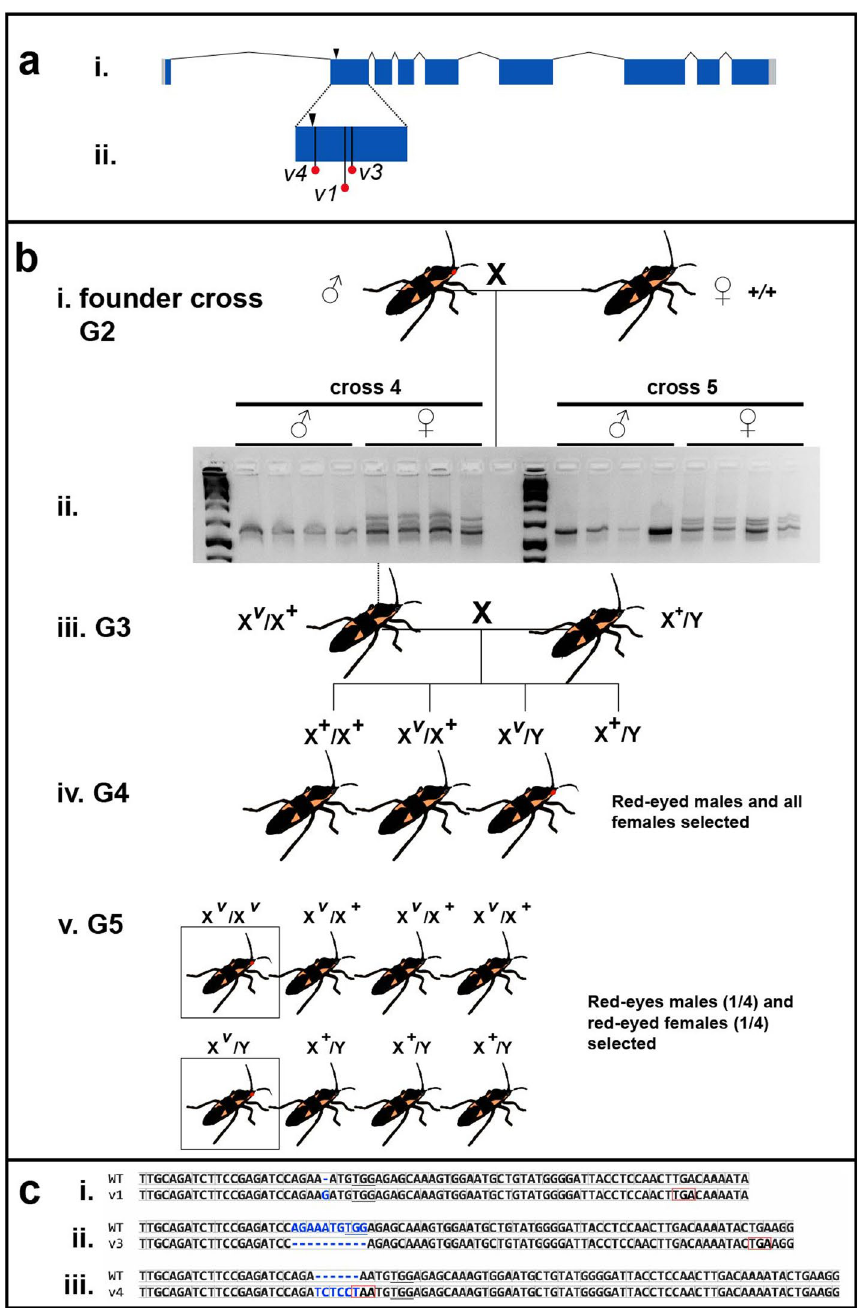
Figure 3. Generation of Of-v mutant lines using CRISPR/Cas9. ( A ) An Of-v gRNA was designed to guide Cas9 to generate a double-stranded break (arrowhead) in Of-v exon 2. (i) Of-v gene structure, with coding DNA sequence shown in dark blue and untranslated regions shown in light gray. (ii) Premature stop codons found in exon 2 of all mutant alleles. ( B ) Crossing scheme to generate homozygous lines from a heteroallelic Of-v mutant stock. (i) Five single crosses were set up between a single red-eyed Of-v G2 male founder (derived from the heteroallelic Of-v population) and three wild-type virgin females. (ii) Of-v exon 2 was amplified from genomic DNA isolated from the progeny of these crosses and a heteroduplex mobility assay performed; all females gave rise to heteroduplex bands, while no heteroduplex bands were found in male samples, consistent with Of-v X linkage; (iii) One G3 female offspring from each founder cross was mated with one or more wild type males; (iv) Male G4 offspring had either red or black eyes, while all female G4s had black eyes. All red-eyed males were selected to mate with female siblings; (v) In the G5, all red-eyed males and red-eyed virgin females were selected to establish homozygous lines. The expected genotypes and phenotypes are shown in their expected proportions. ( C ) Alignment between the wild-type Of-v allele and the three mutant alleles for which homozygous lines were successfully established: (i) v 1 , single nucleotide insertion at the predicted double-stranded break site; (ii) v 3 , 10 bp deletion; (iii) v 4 , 6 bp insertion. Insertions or deletions, blue. Reading frame, light gray boxes. Introduced stop codons, red boxes. PAM site,